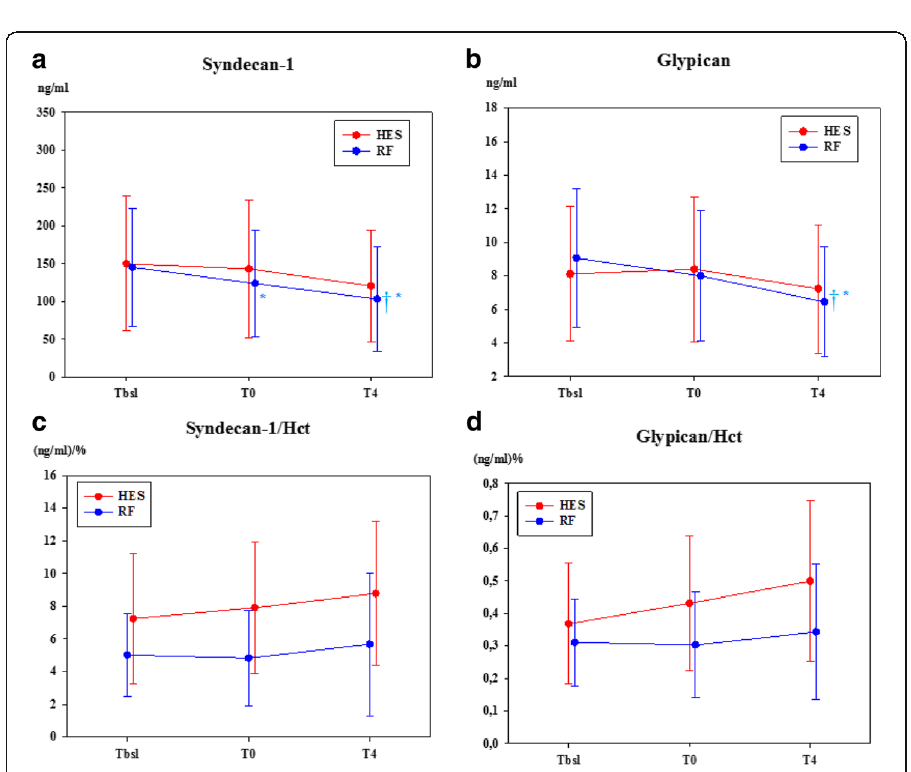
Fig. 4 Endothelial function. Plasma concentrations of syndecan-1 ( a ), glypican ( b ), syndecan-1 hematocrit ratio ( c ) and the glypican hematocrit ratio ( d ) are delineated. Data are presented as mean±standard deviation. HES = colloid group, RF = crystalloid group. * p <0.05 significantly different from T bsl . † p <0.05 significantly different from T 0 . # p <0.05 significantly different between